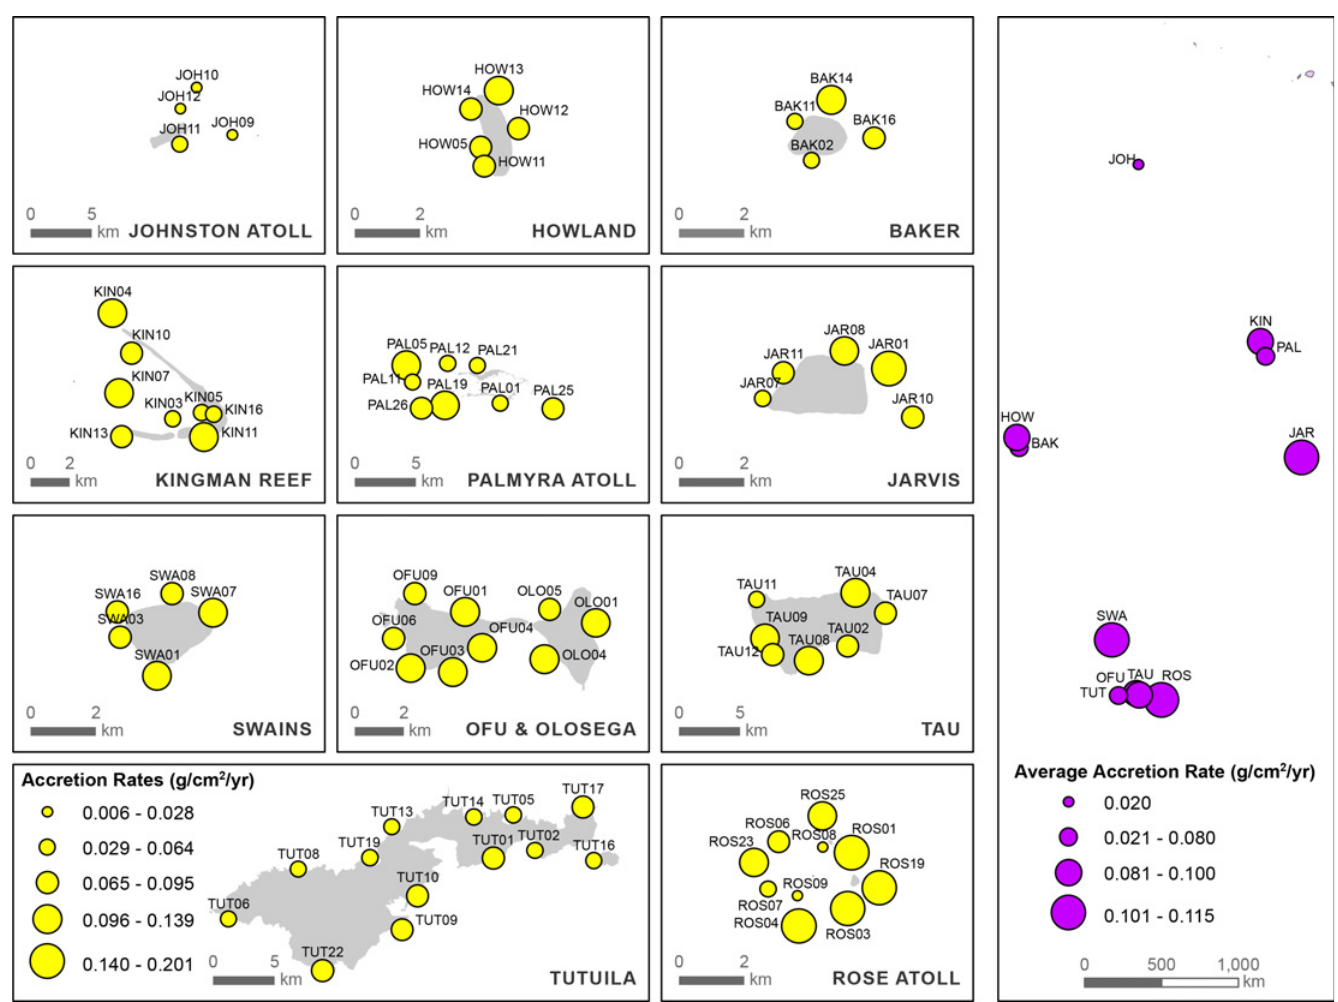
Fig 3. Spatial distribution and mean carbonate accretion rates derived from CAU deployments by study site (left panel) and island-wide (right